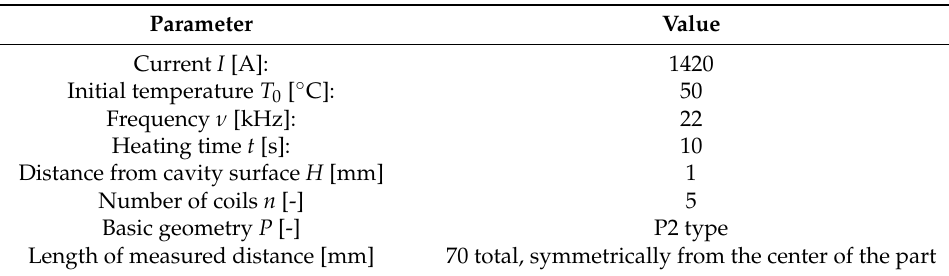
Table 2. Input data for simulation